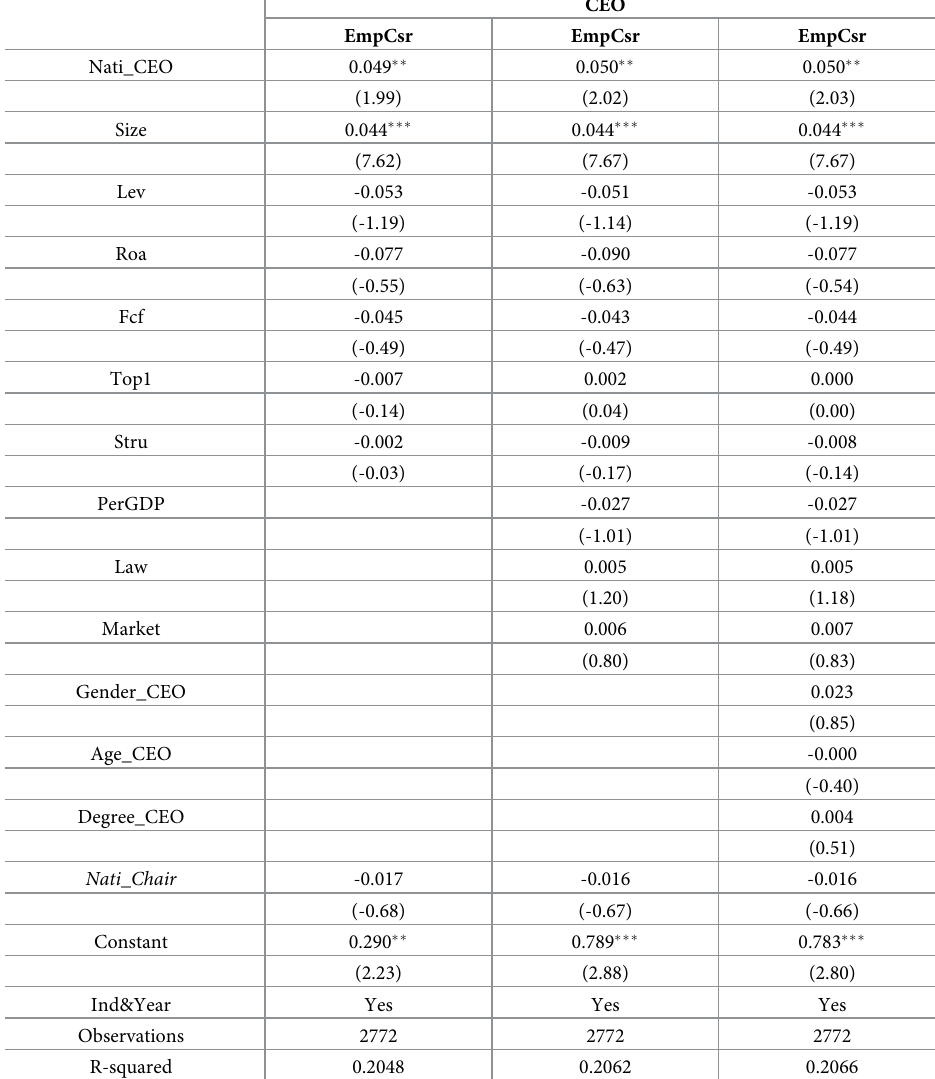
Table 8. Control home bias of